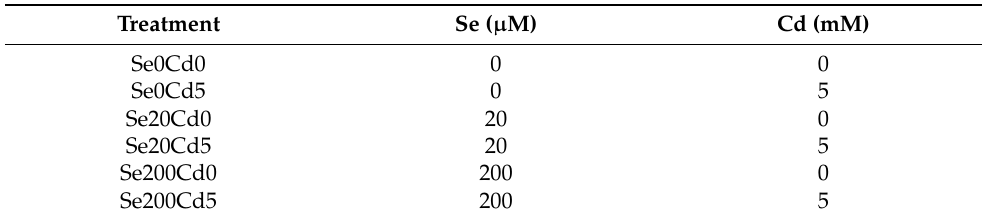
Table 1. Experimental